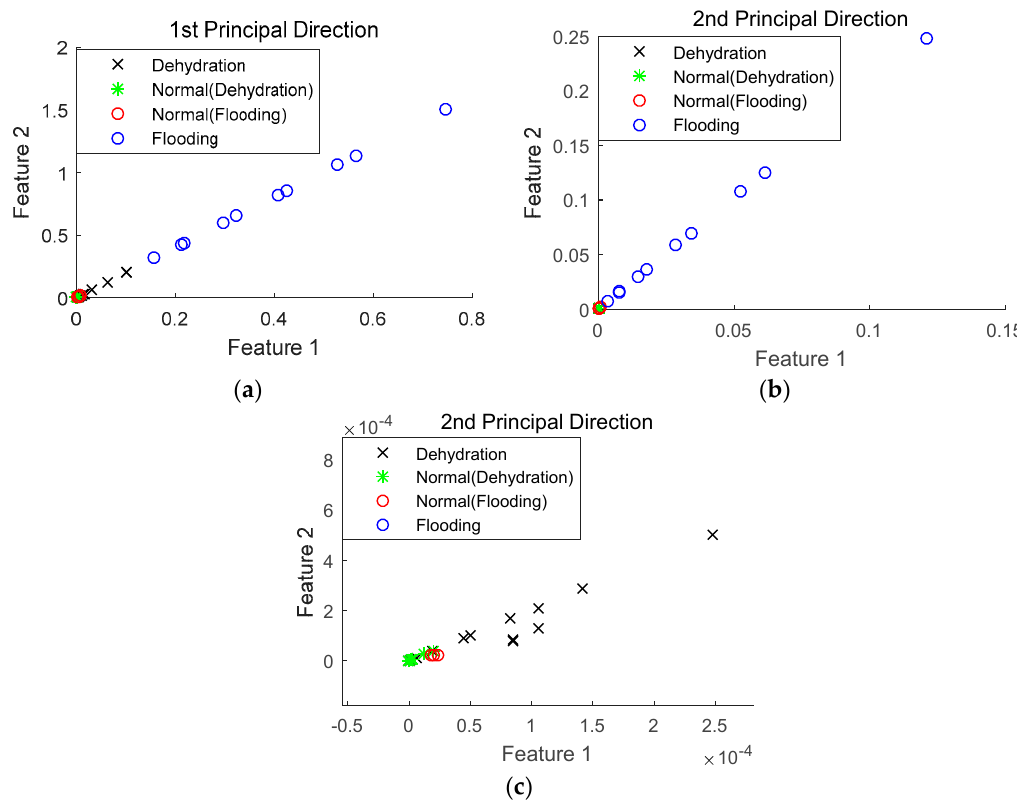
Figure 4. Fault diagnosis performance using selected sensors. ( a ) 1st principal direction; ( b ) 2nd principal direction; ( c ) zoom in the 2nd principal